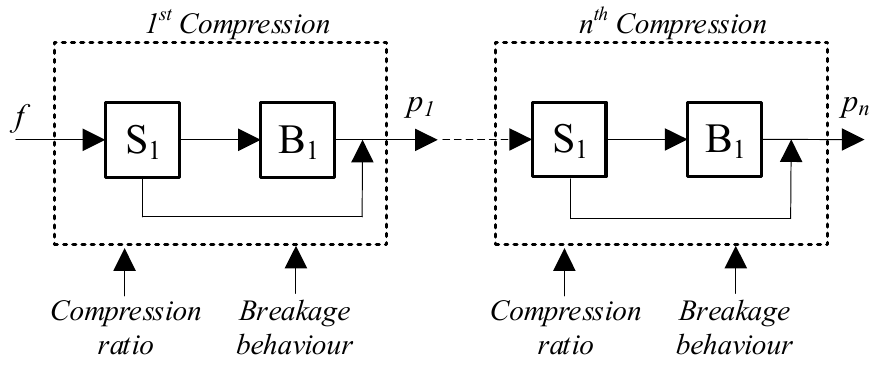
Figure 4. Schematic representation of the crusher model [5,12] .